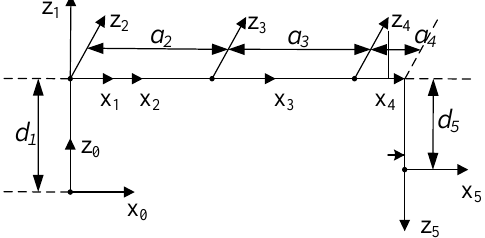
Figure 3. Linkage coordinate system of the pickup manipulator.